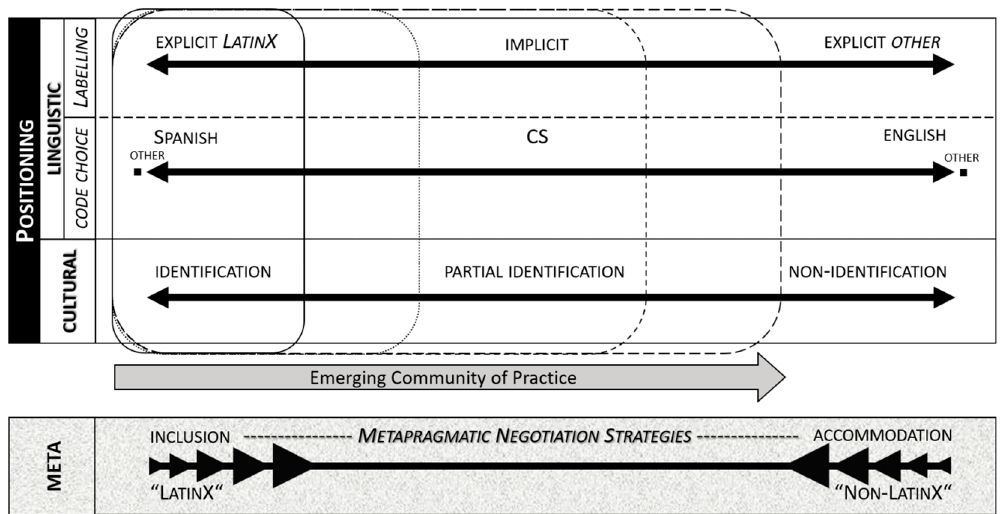
Figure 3. A Holistic Model of Positioning: An Emerging Community of Practice.